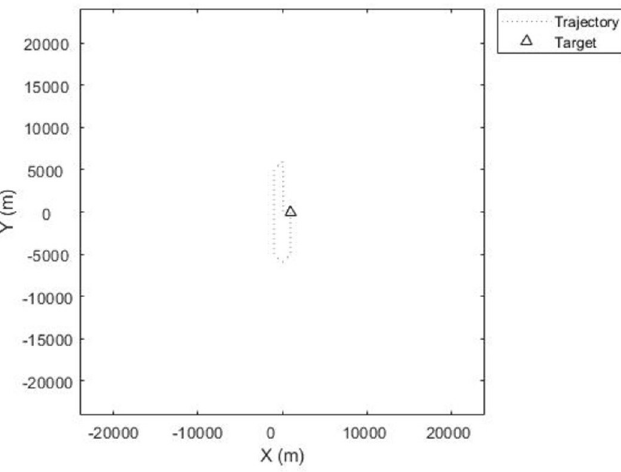
Fig 2. Target drone racetrack path with straight legs of 20 km and a turn radius of 2 km.